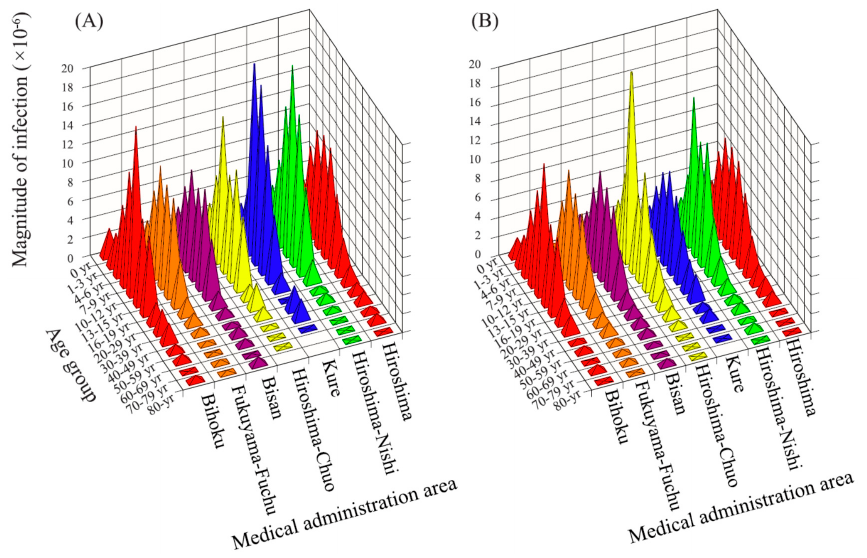
Figure 3. The expansion of infection. The expansion of infection is shown by age group and by medical administration area: male ( A ); and female ( B ). Int. J. Environ. Res. Public Health 2016 , 13 , x FOR PEER REVIEW